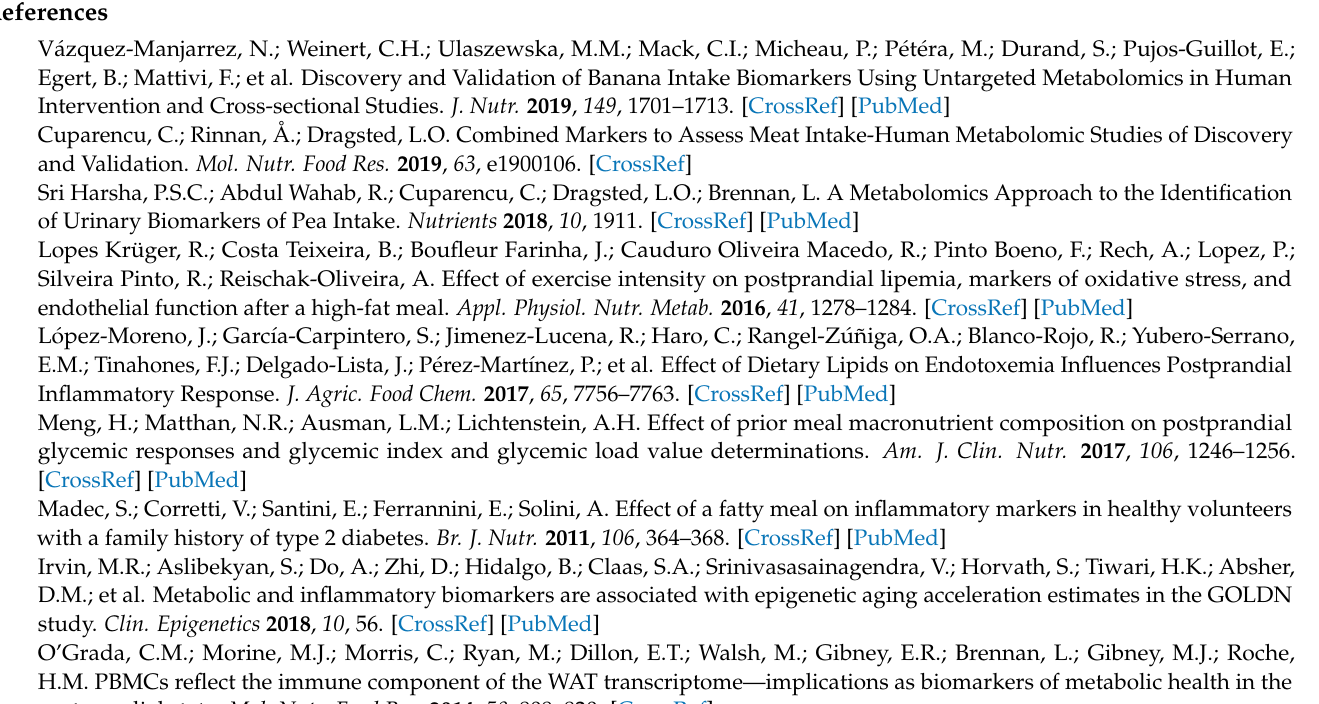
values. Table S4: Characterization of the postprandial response (iAUC 0–6 h) of metabolic, hormonal, and inflammatory variables in NW ( n = 15) and OB ( n = 17) men having consumed 500, 1000, and 1500 kcal of the HF meal. Table S5: Correlation coefficients and FDR values of postprandial iAUC clinical data with 52 iAUC LC-MS results for NW